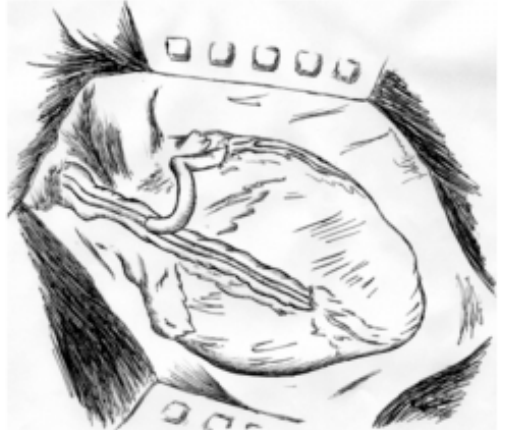
Fig. 1 - Esquema de um enxerto composto de ATIE com VSM revascularizando a AIA e uma artéria marginal da circunflexa, respectivamente.